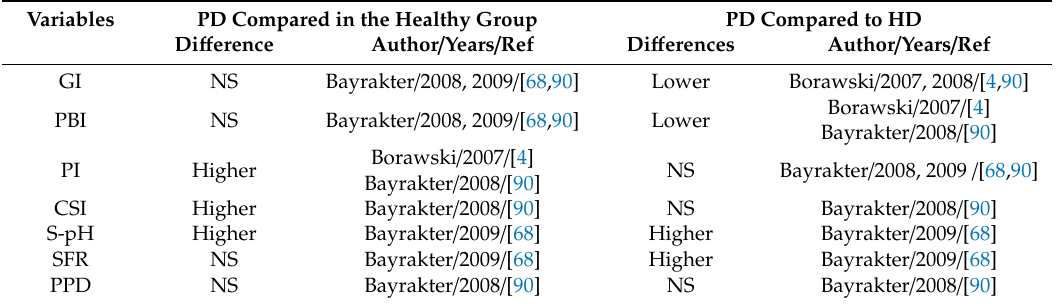
Table 7. Periodontal parameters in the peritoneal dialysis, hemodialysis, and healthy groups.